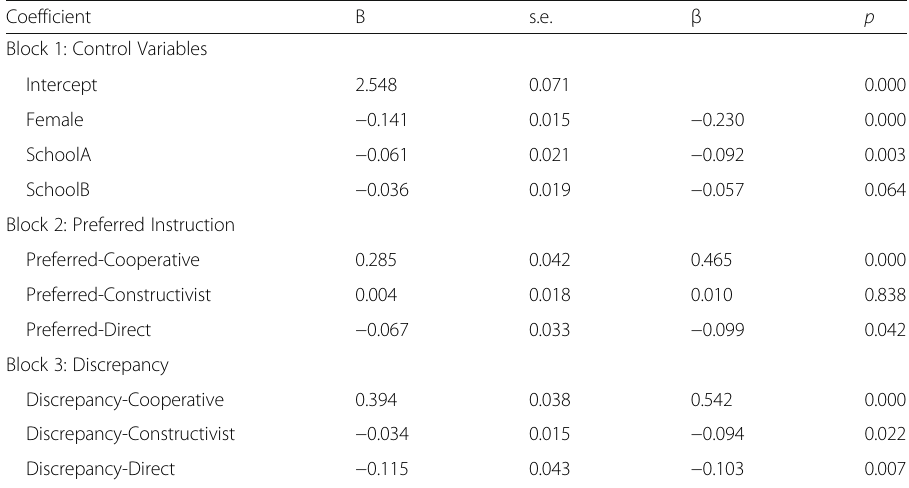
Table 7 Multiple regression analysis for attitude toward science ( N = 1299) Coefficient B s.e.